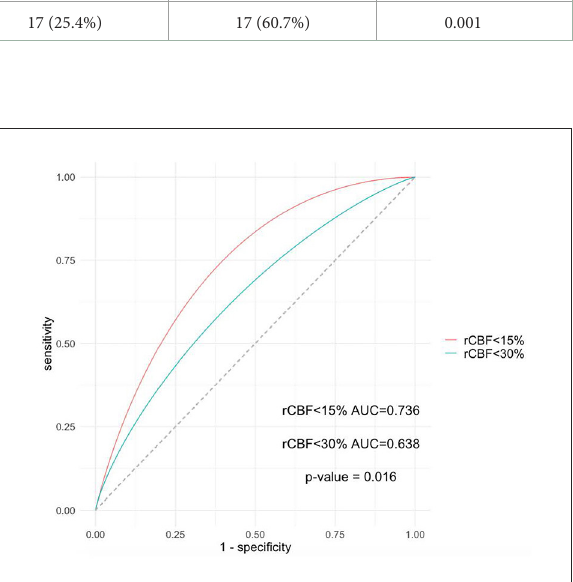
FIGURE2 Receiver operating characteristic analyses of the rCBF < 15% volume and rCBF < 30% volume. An rCBF < 15% volume showed a better predictive value of MLS than an rCBF < 30% volume (AUC, 0.735 vs. 0.646, P = 0.023). rCBF indicates relative cerebral blood flow; AUC indicates the area under the